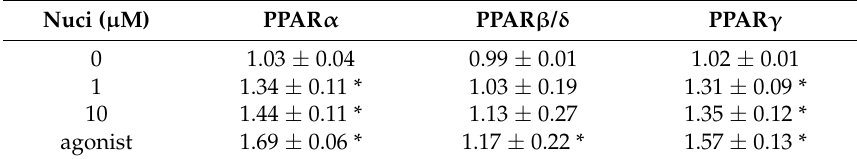
Figure 3. Effect of Nuciferine on PPARs transcription activities. ( A – C ) Luciferase reporter assay in RAW264.7 cells. ( D ) The relative mRNA expression of PPARs target genes. * p < 0.05 ** p < 0.01 vs. control. Table 2. Effect of Nuciferine on PPARs transcription activities in RAW264.7 cells.